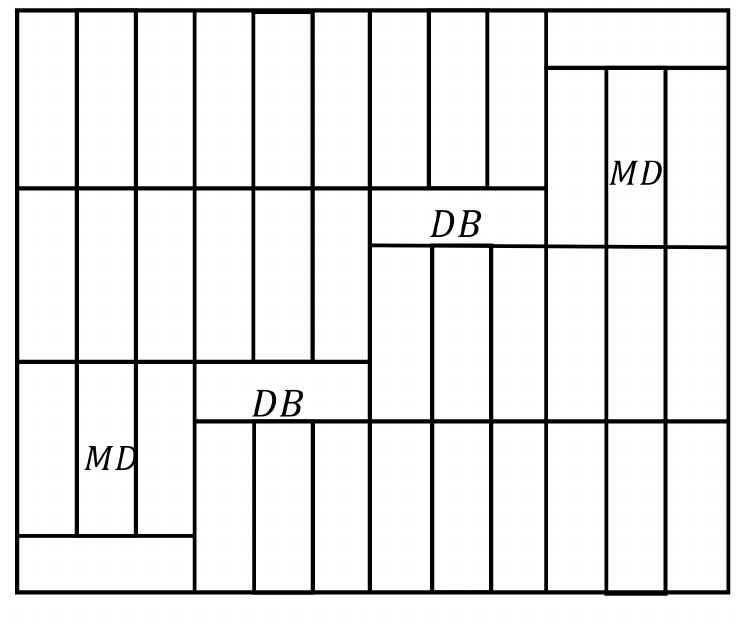
Figure 4. Hollow block